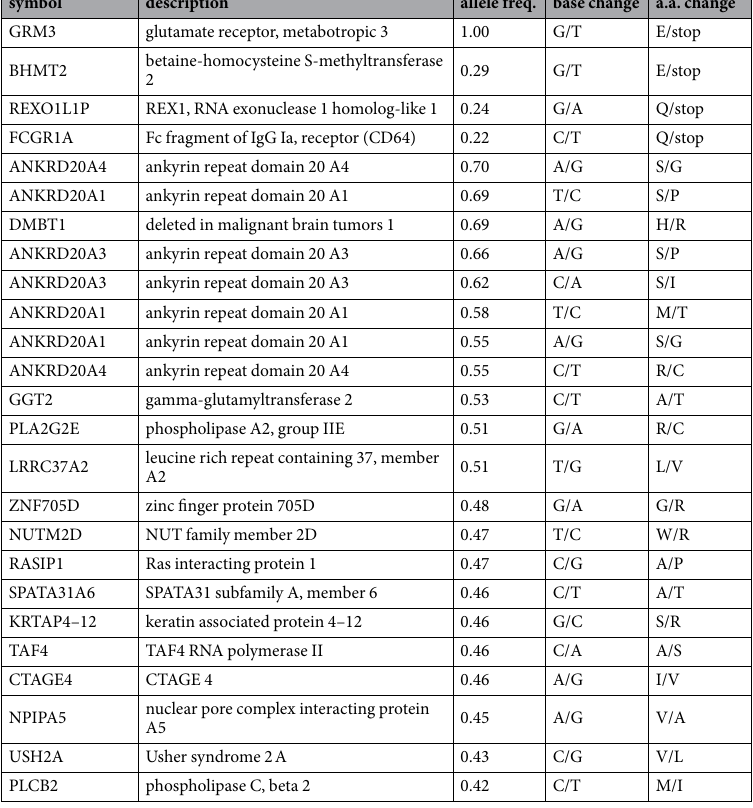
Table 1. Mutations in BMD